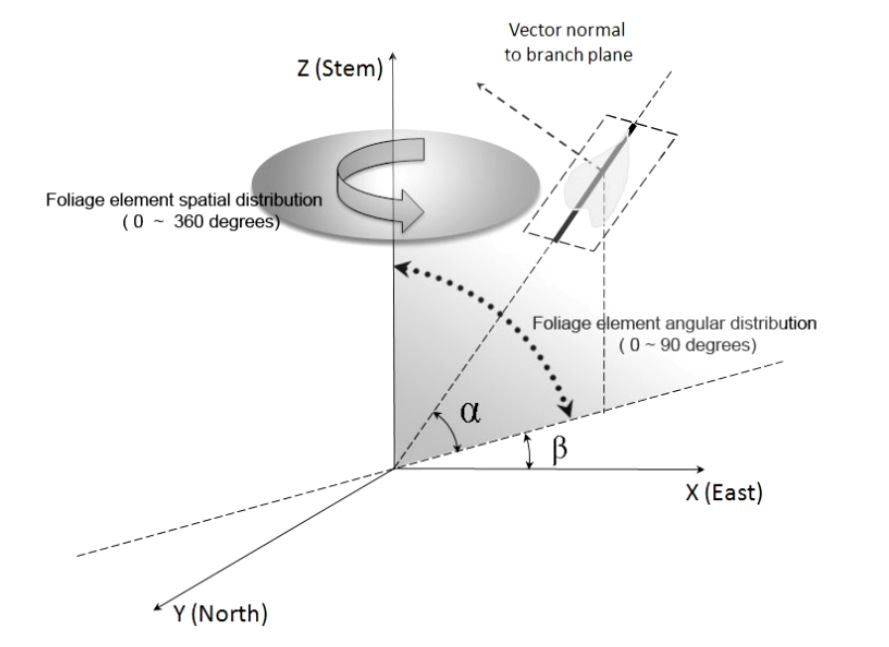
Figure 2. Schematic diagram illustrating the spatial and angular distribution for a single leaf ( β is the azimuthal angle for this individual leaf ranging from 0 to 360 degrees, and α is the inclination angle of this single leaf, whose range is from 0 to 90